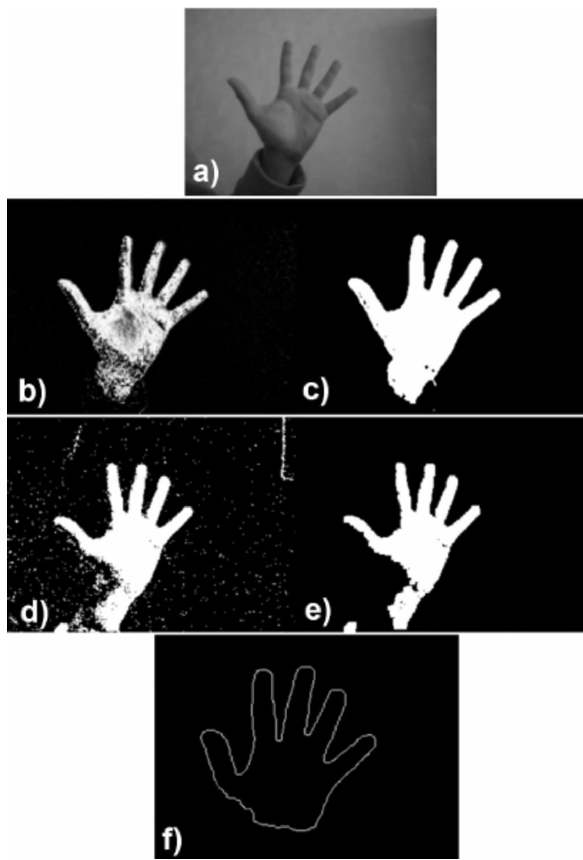
Figure 3. (a) original image with hand; (b) image of hand after skin color detection; (c) after morphological operations and bi- narization; (d) image of hand after background extraction ; (e) after binarization and morphological operations; (f) hand’s con- tour made of image c and image e